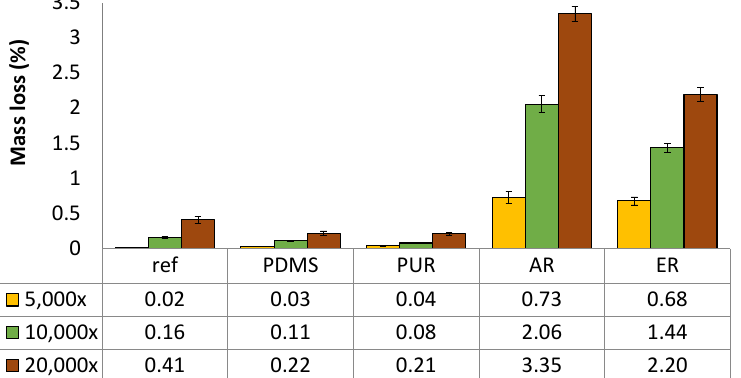
Figure 4. Mass loss of polymer coated PES samples, measured at 5,000, 10,000 and 20,000 rubbing cycles.